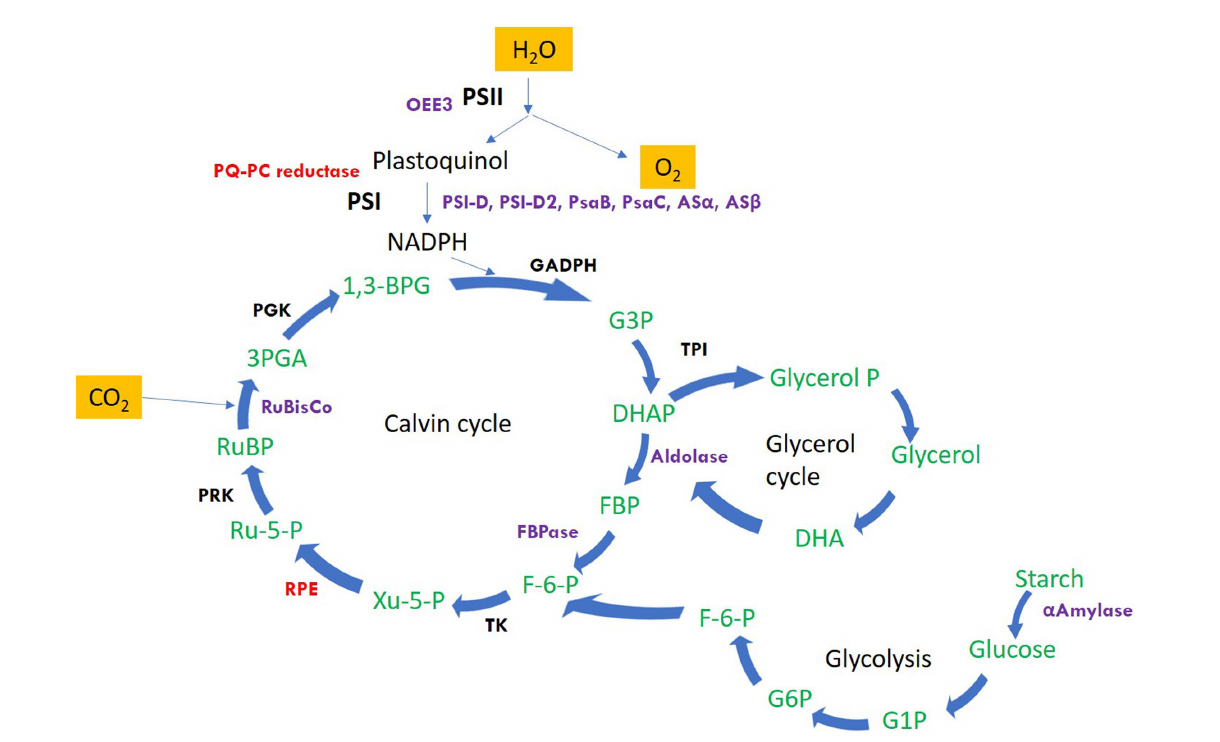
FIGURE 2 Schematic representation of the regulation of photosynthetic machinery and C assimilation in P. salinarum SLJS6 under highly saline alkaline conditions as per the results obtained in this study. Only the proteins that showed significant differential abundance are highlighted (Purple: significantly upregulated; Red: significantly down-regulated). Other proteins/enzymes of the depicted pathways were also differentially altered but were not significant (details of such proteins is given in Supplementary Tables). PSI-D, photosystem I reaction center subunit II; PSI-D2, photosystem I reaction center subunit II-2; PsaB, photosystem I P700 chlorophyll a apoprotein A1; PsaC, photosystem I iron-sulfur center; As α , ATP synthase subunit alpha; As β , ATP synthase subunit beta; OEE3, oxygen-evolving enhancer protein 3; PQ-PC reductase, plastoquinone plastocyanin reductase; FBPase, fructose-1,6-bisphosphatase; FBA, fructose-bisphosphate aldolase; RuBisco, ribulose bisphosphate carboxylase; RPE, ribulosephosphate 3-epimerase; GAPDH, glyceraldehyde 3-phosphate dehydrogenase; G3P, glyceraldehyde 3-phosphate; TPI, triosephosphate isomerase; DHAP, dihydroxyacetone phosphate; FBP, fructose-1,6-bisphosphate; F-6-P, fructose-6-phosphate; Ru-5-P, ribulose 5-phosphate; PRK, phosphoribulokinase; RuBP, ribulose- 1,5-bisphosphate; 3PGA, 3-phosphoglycerate; PGK, phosphoglycerate kinase; 1,3-BPG, 1,3-bisphosphoglycerate; TK,